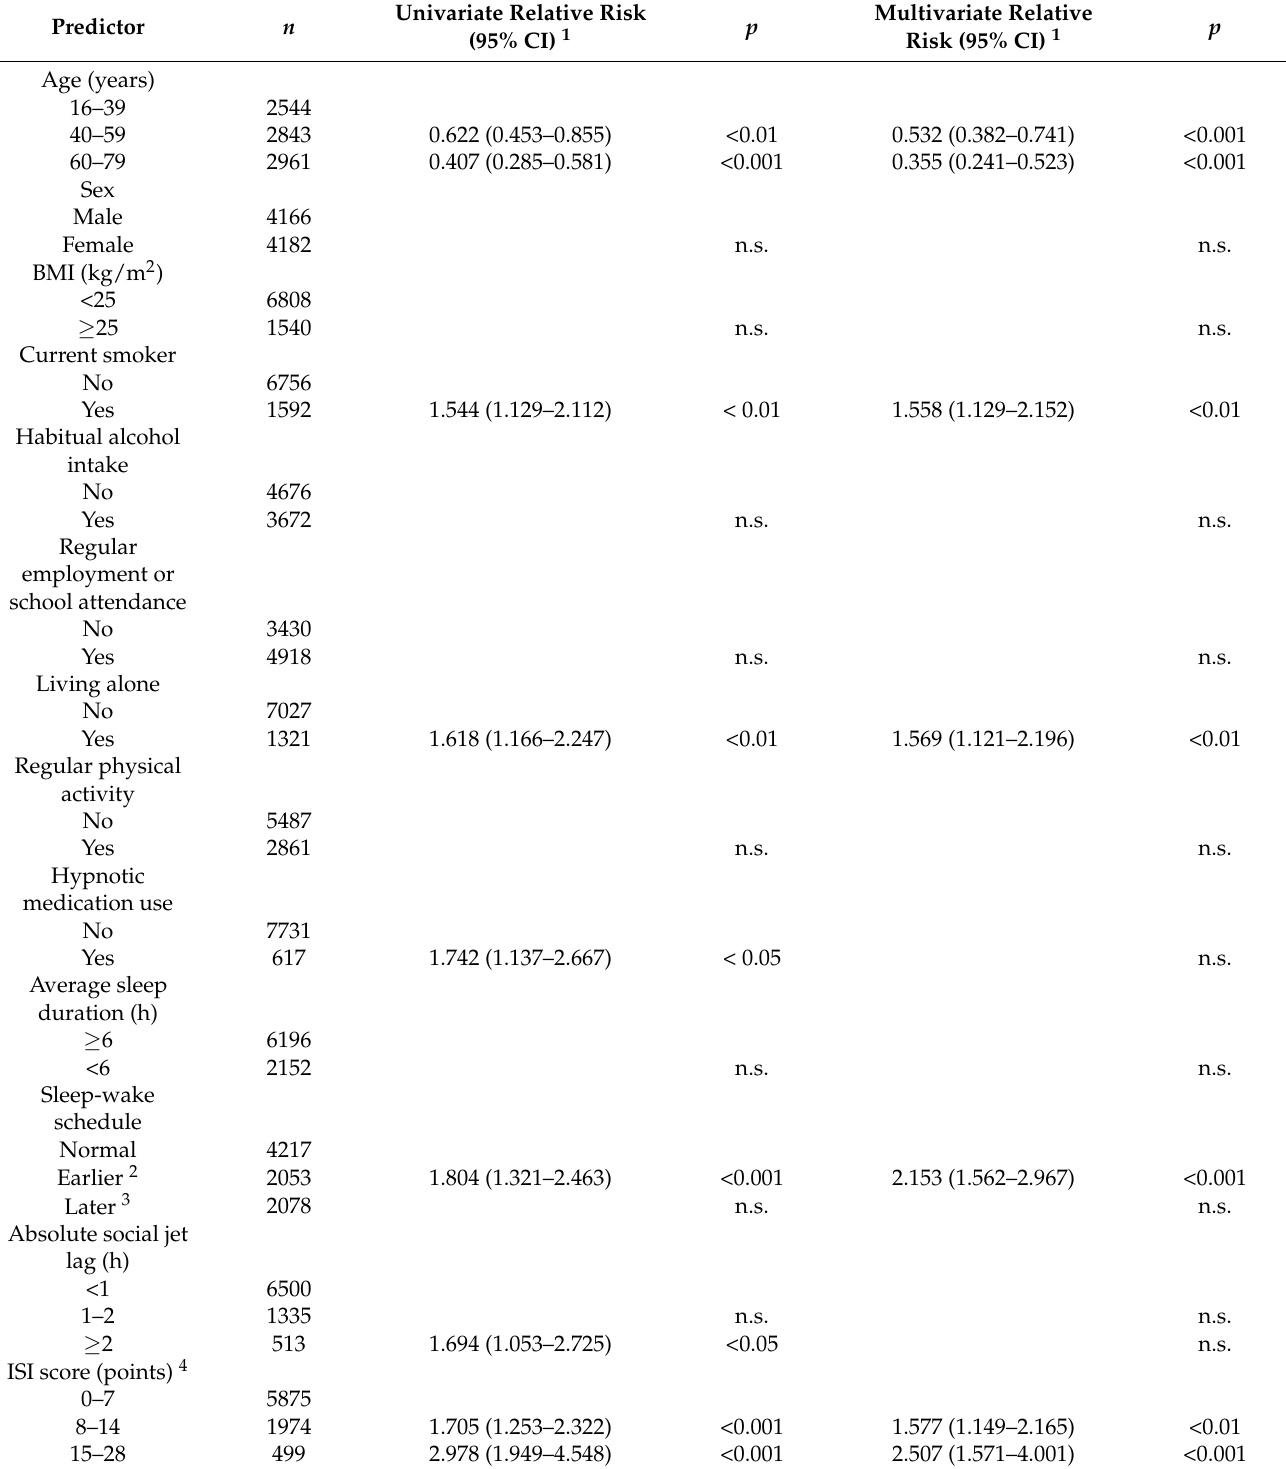
Table 3. Factors associated with nocturnal ingestion ( n =